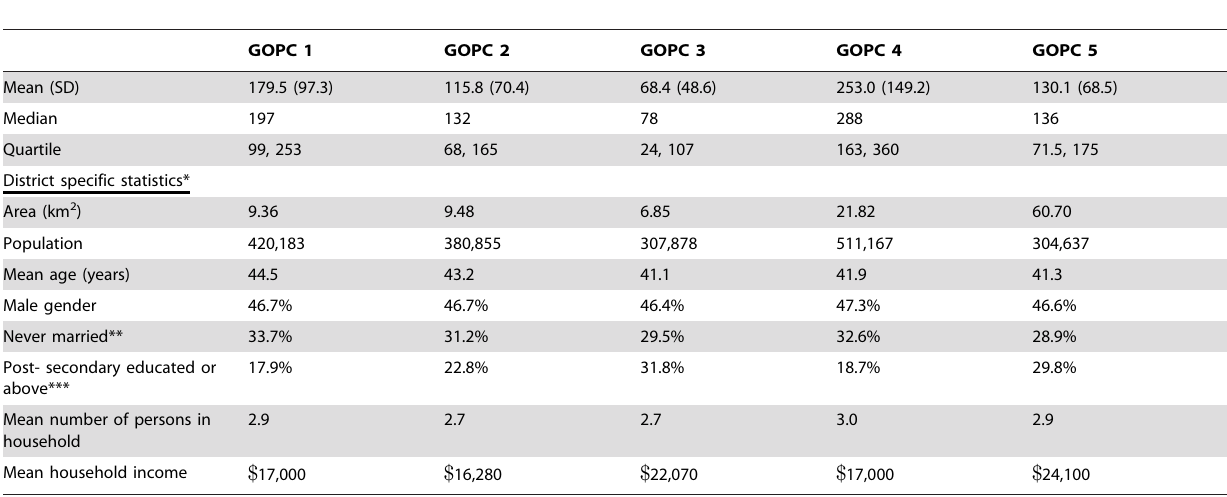
Table 1. Daily number of URTIs consultations at the five GOPCs, and district specific statistics, from 1 Jan 2008 to 31 Dec 2010.